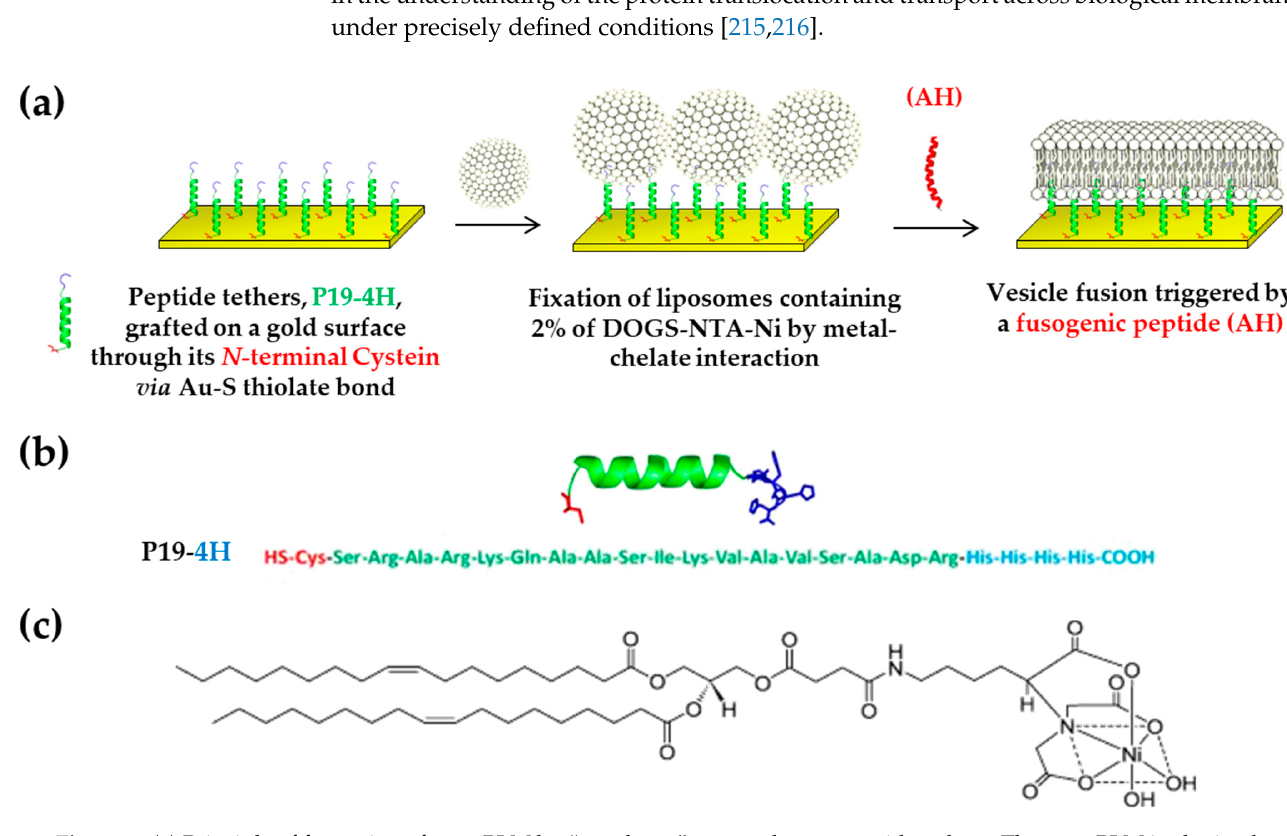
Figure 2. ( a ) Principle of formation of pep-tBLM by “top-down” approach onto peptide tethers. The pep-tBLM is obtained after vesicle fusion of liposomes containing 2% of a chelating lipid DOGS-NTA-Ni, tethered onto P19-4H peptides, grafted themselves on gold surface via stable Au-thiolate bond; the vesicle fusion is triggered by an amphipathic α -helix (AH) peptide derived from the N-terminus of the hepatitis C virus NS5A protein; ( b ) 3D modelling of P19-4H; the three characteristic parts of the peptide are represented with the cysteine residue in red for the grafting on the gold surface, the central α -helix in green for the spacing and the 4 Histidine residues in blue for the attachment of liposomes containing DOGS-NTA by chelation in the presence of nickel salt. The sequence of P19-4H and P19 peptide from which P19-4H has been derived are indicated below; ( c ) Structure of the DOGS-NTA-Ni able to interact specifically with P19-4H (adapted with permission from [200]. Copyright 2017, American Chemical Society).